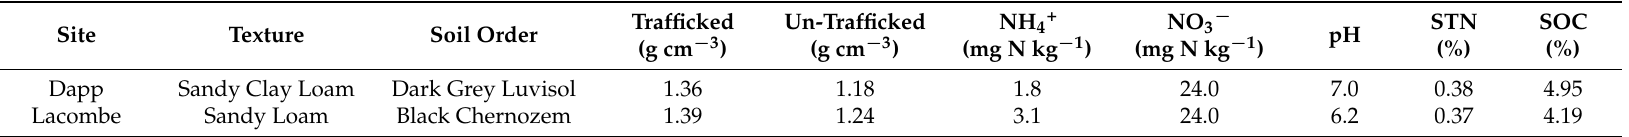
Table 1. Soil type and characteristics. Shows both soil types used in the study and their respective mean values for given attributes. Mean values in table determined from undisturbed soil core samples ( n = 96) taken from each field site at a depth of 5–15 cm.